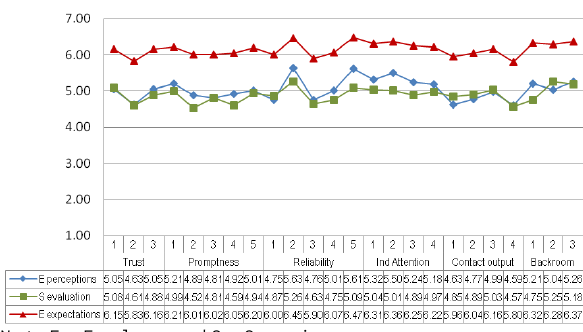
Figure 1. Employees’ self- reported